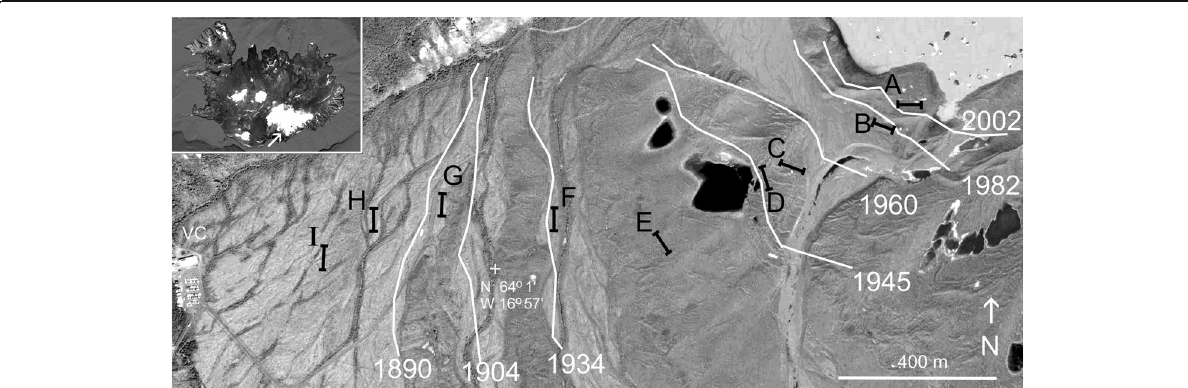
Fig. 1 Map of the sampling sites on the Skaftafellsjökull foreland for 2007 and 2014 with estimated positions of the ice front (see text). Black line segments mark the sample transect locations. Darker areas on the foreland are moraines; lighter areas are terraces of abandoned melt-water streams and bars on the distal outwash plain. These are incised by narrow channels that are darker due to the higher proportion of shrubs and low trees. Inset shows the location of Skaftafellsjökull outlet glacier on southern margin of the Vatnajökull. VC = park visitor center. Figure adapted from imagery downloaded from Google Earth® (image acquisition date August 10,